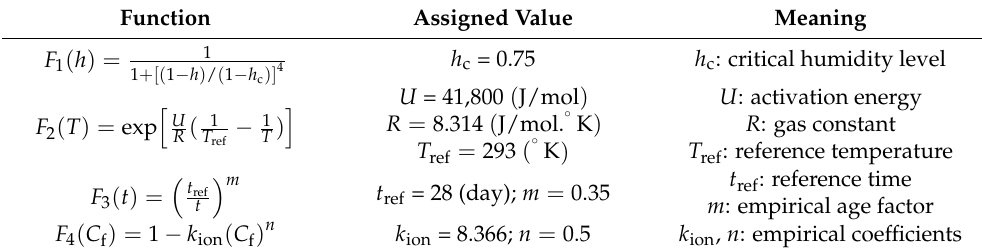
Table 1. Mathematical descriptions of the influence coefficients.